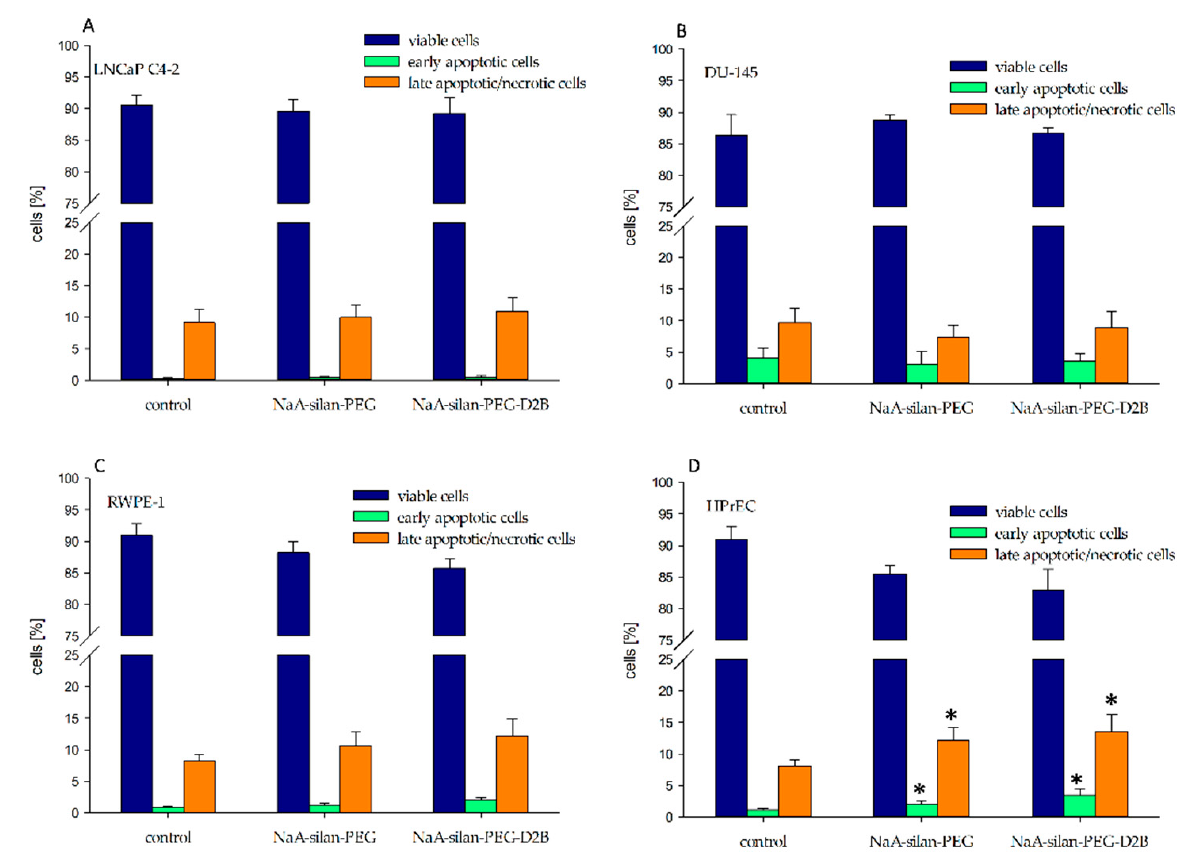
Figure 2. The effect of NaA-silane-PEG and NaA-silane-PEG-D2B on the proportion of viable cells (annexin V-negative and propidium iodide-negative cells), early apoptotic cells (annexin V-positive cells and propidium iodide-negative cells) and late apoptotic/necrotic cells (annexin V-positive and propidium iodide-positive cells). LNCaP C4-2 cells ( A ), DU-145 cells ( B ), RWPE-1 cells ( C ) and HPrEC cells ( D ) were exposed to 50 mcg mL − 1 of NaA-silane-PEG or NaA-silane-PEG-D2B for 96 h. Data are expressed as the mean ± standard deviation (SD) from three independent experiments. * p < 0.05 versus control group.